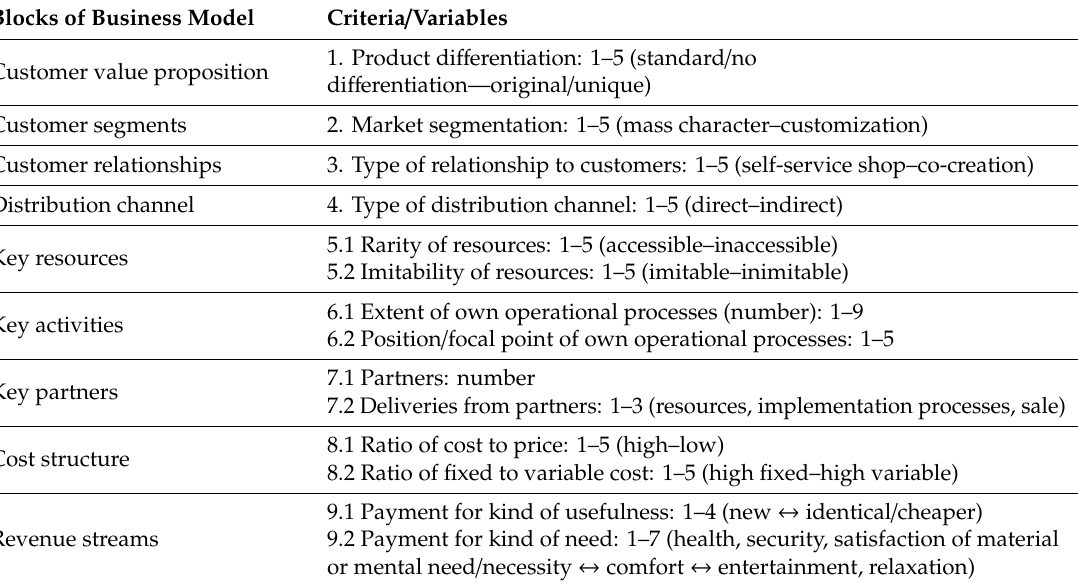
Table 1. Descriptive criteria of the business